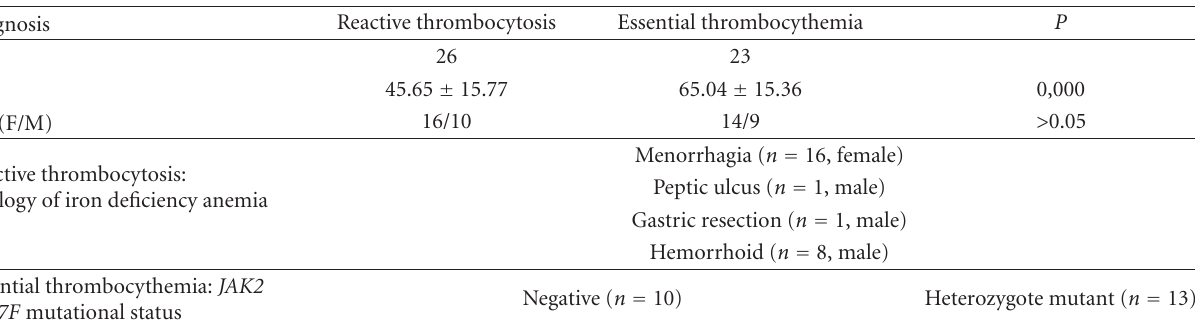
Table 1: The demographic characteristics of